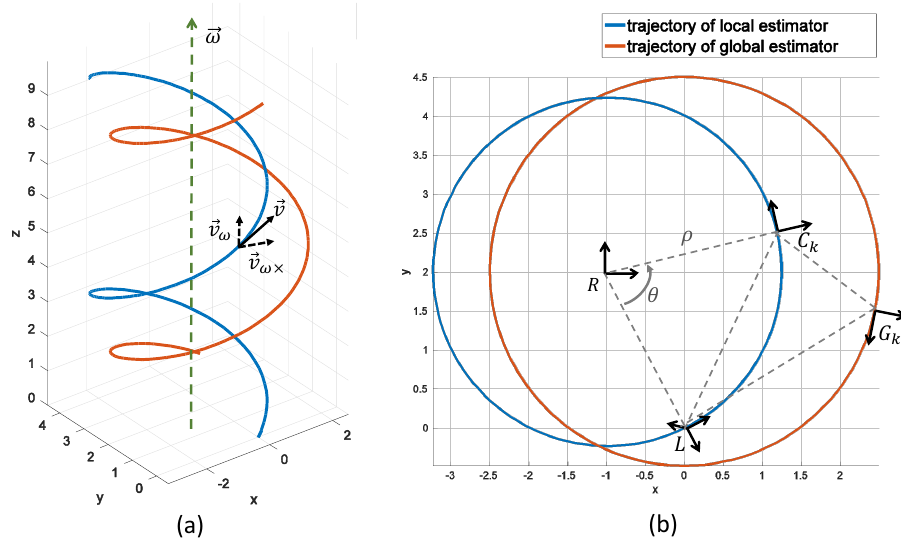
Figure A1. This figure demonstrates ( a ) the 3D trajectory of one-axis rotation movement with constant angular and translational velocity and ( b ) its projected trajectory viewed along the rotational